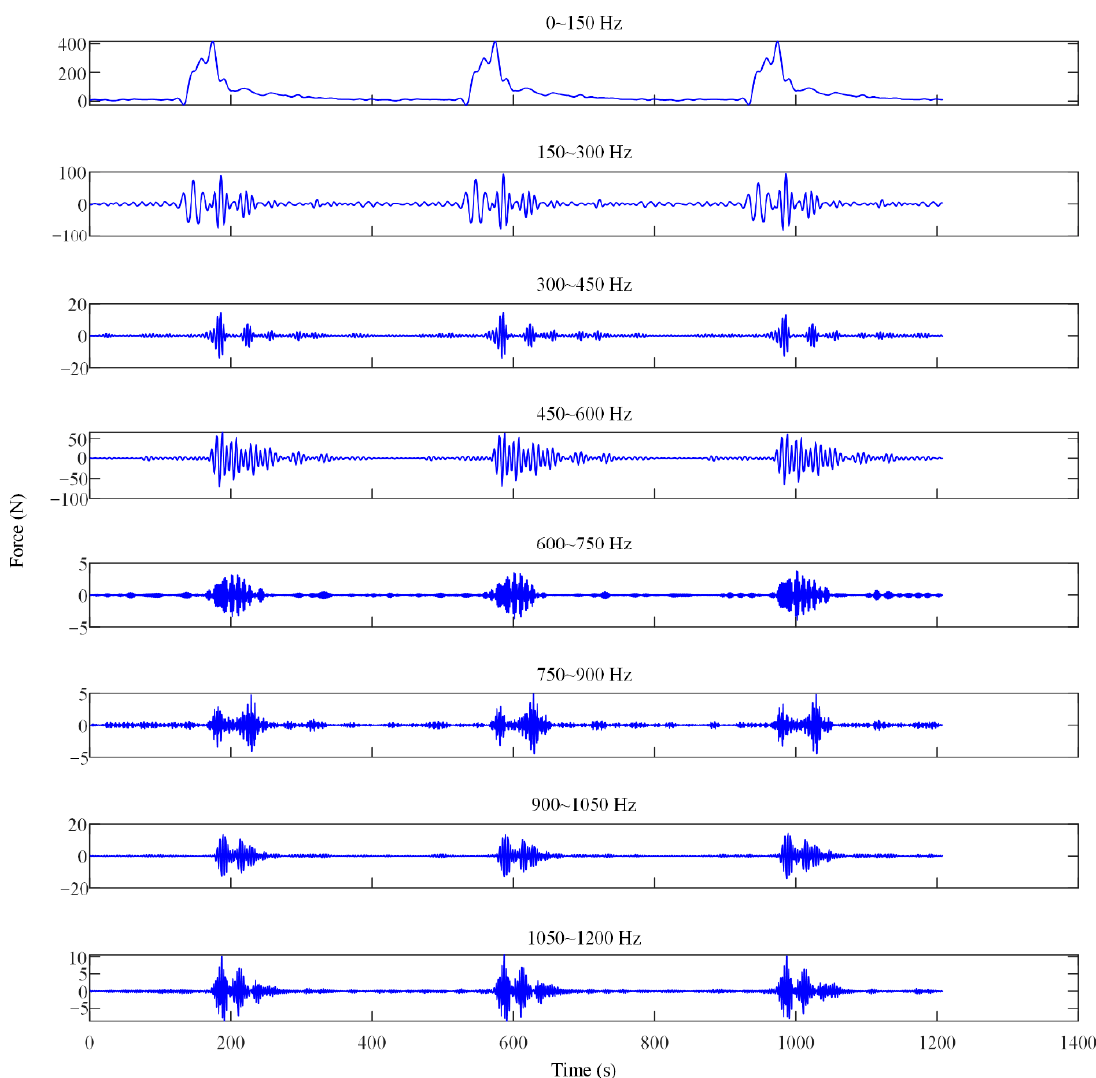
Figure 10. Reconstructed cutting force signals in each frequency band with wavelet packet decomposition.